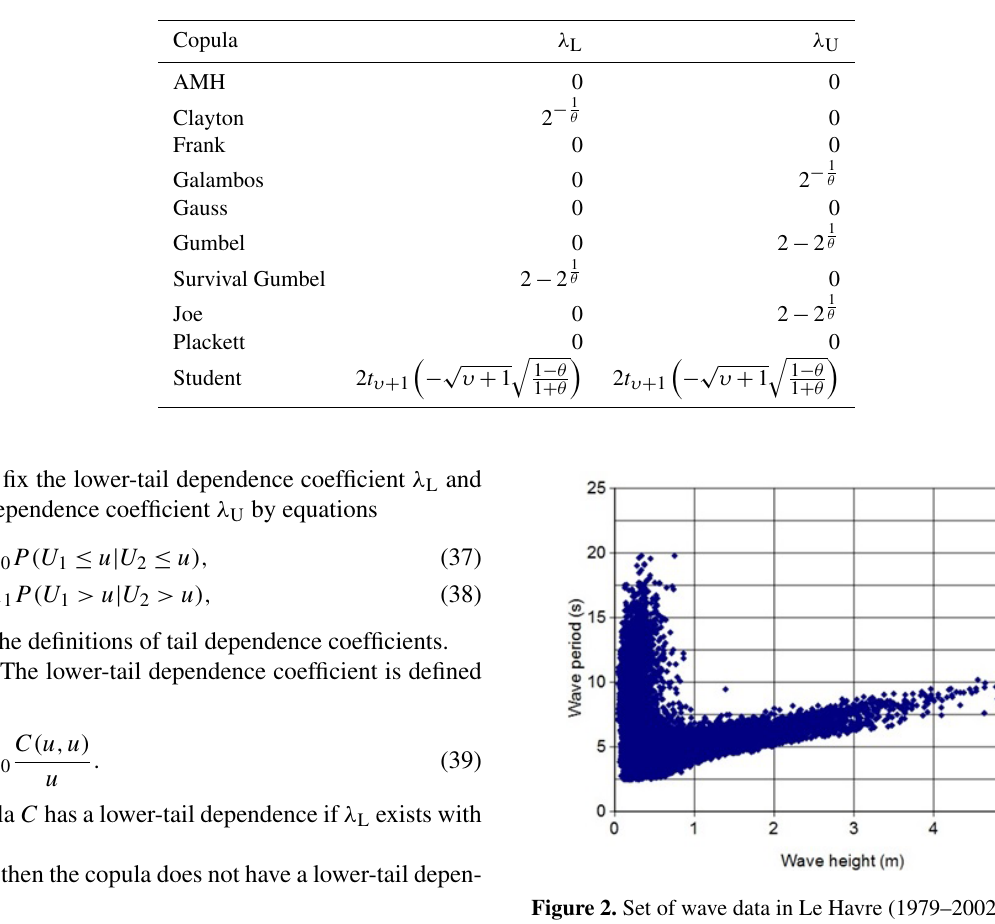
Table 1. Tail dependence coefficients.